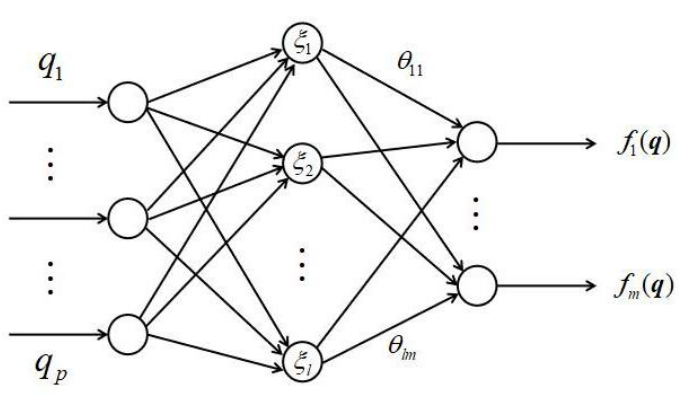
Figure 3. The RBF network